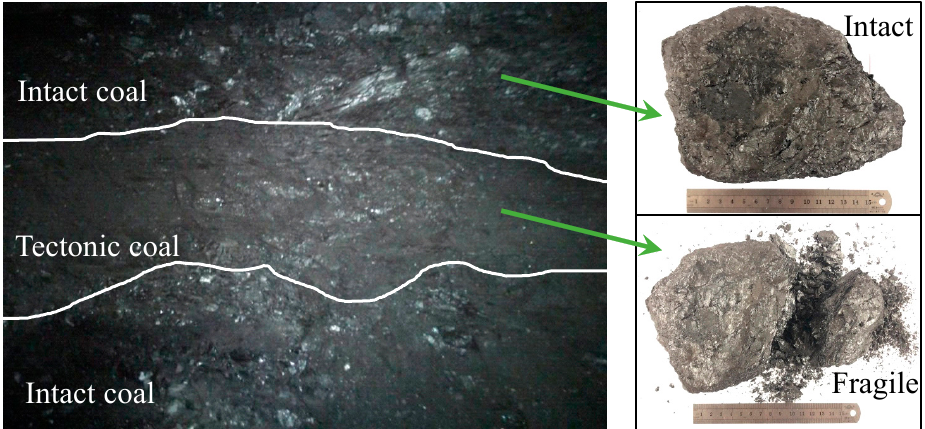
Figure 1. Stratification and morphology of intact coal and tectonic coal at No. 1216(1) working face in Zhangji coal mine.